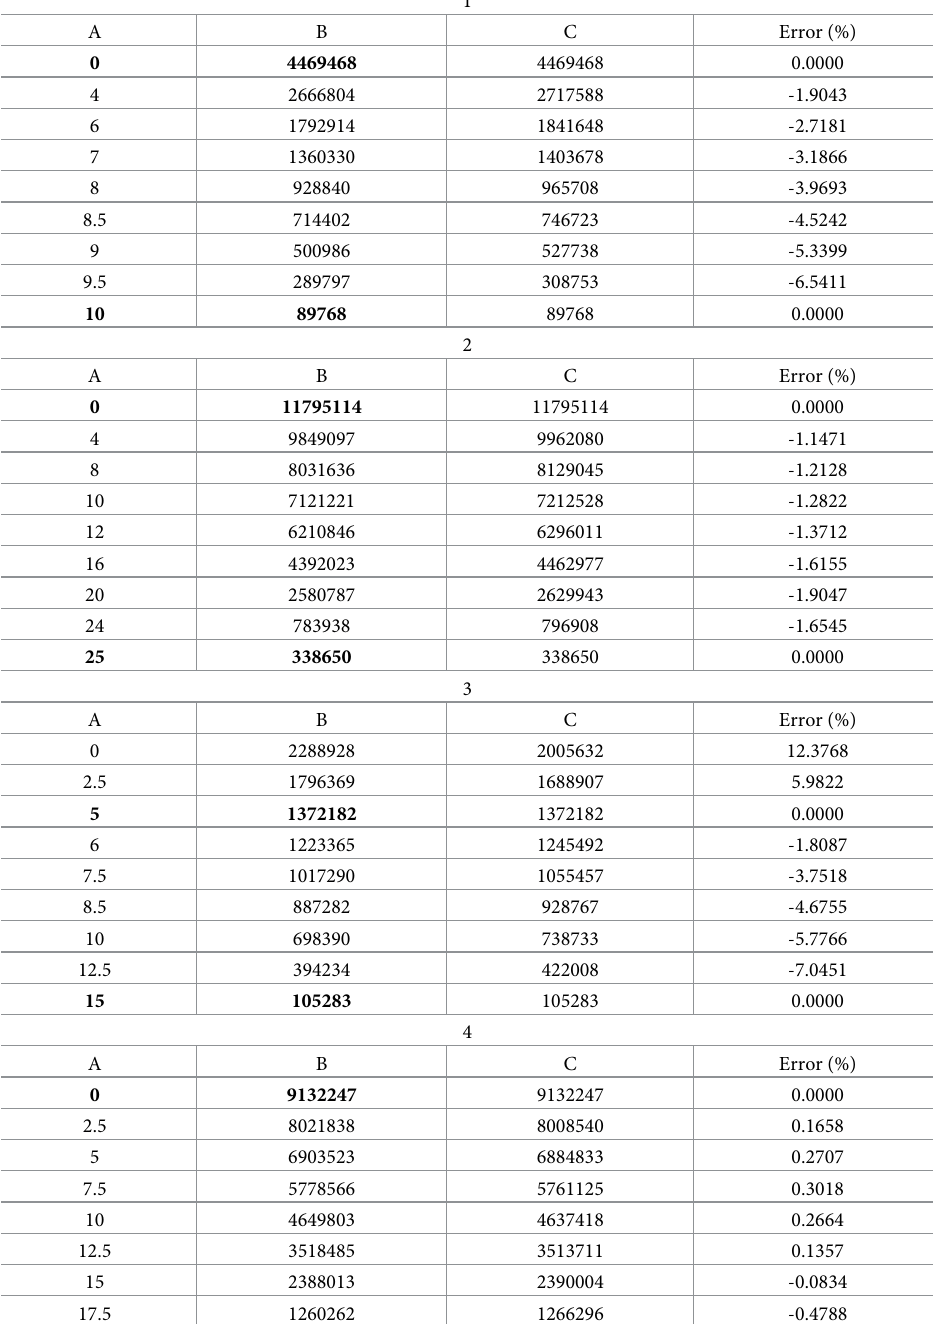
Table 2. The four tables respectively compare the actual fatality count and linear interpolations for policy 1 “both drug and vaccine scenario” and 1) eight cluster star topology—Central (Fig 17a) 2) eight cluster star